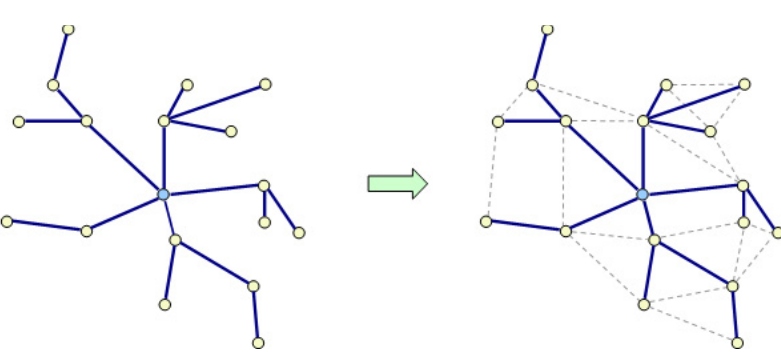
Figure 1. Mesh centralized topology.